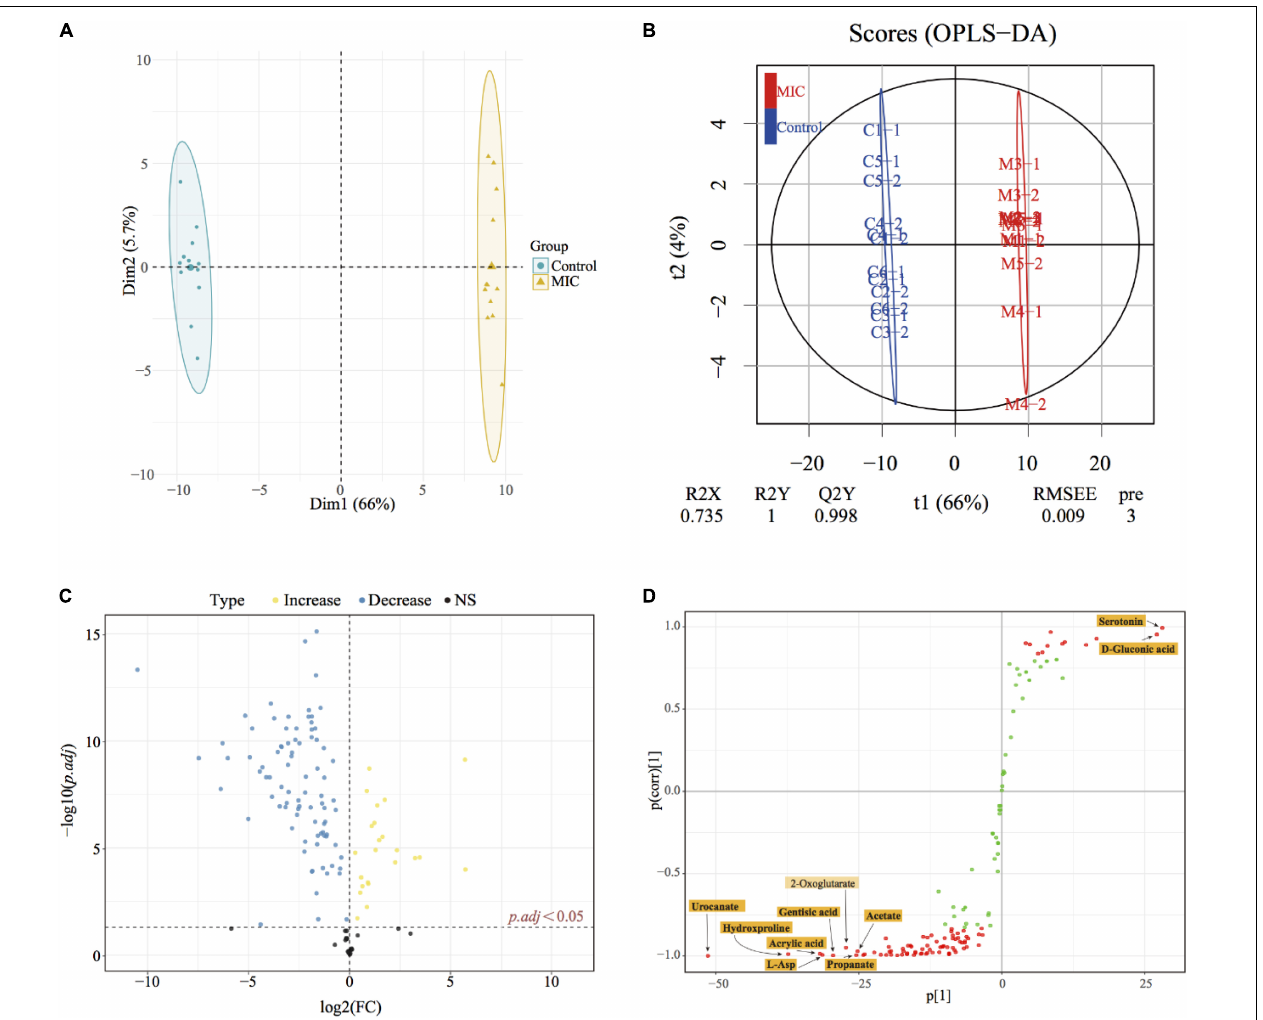
FIGURE 4 | Metabonomics statistical analysis. (A) PCA score plot; (B) OPLS-DA score plot ( R 2 X = 0.735, R 2 Y = 1 Q 2 Y = 0.998). C#-# and M#-# presented the sample name of the control group and MIC group, respectively. (C) Volcano plot; yellow dots represented the increase in metabolite abundance, and blue dots represented the decrease in metabolite abundance (vs. Control). p.adj represented adjusted p -values using FDR. (D) S-plots from the OPLS-DA model, the abscissa indicated the covariance, and the ordinate indicated